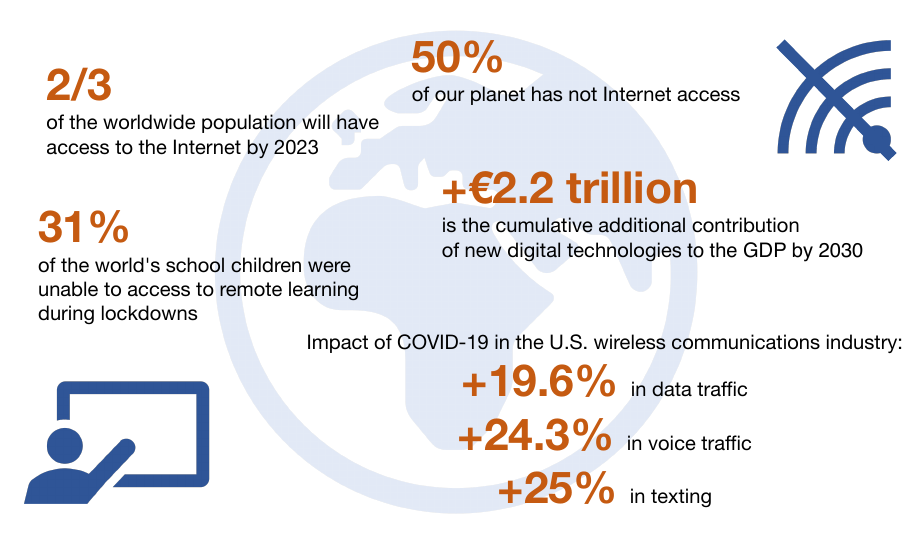
Figure 1. Some numbers on the Digital